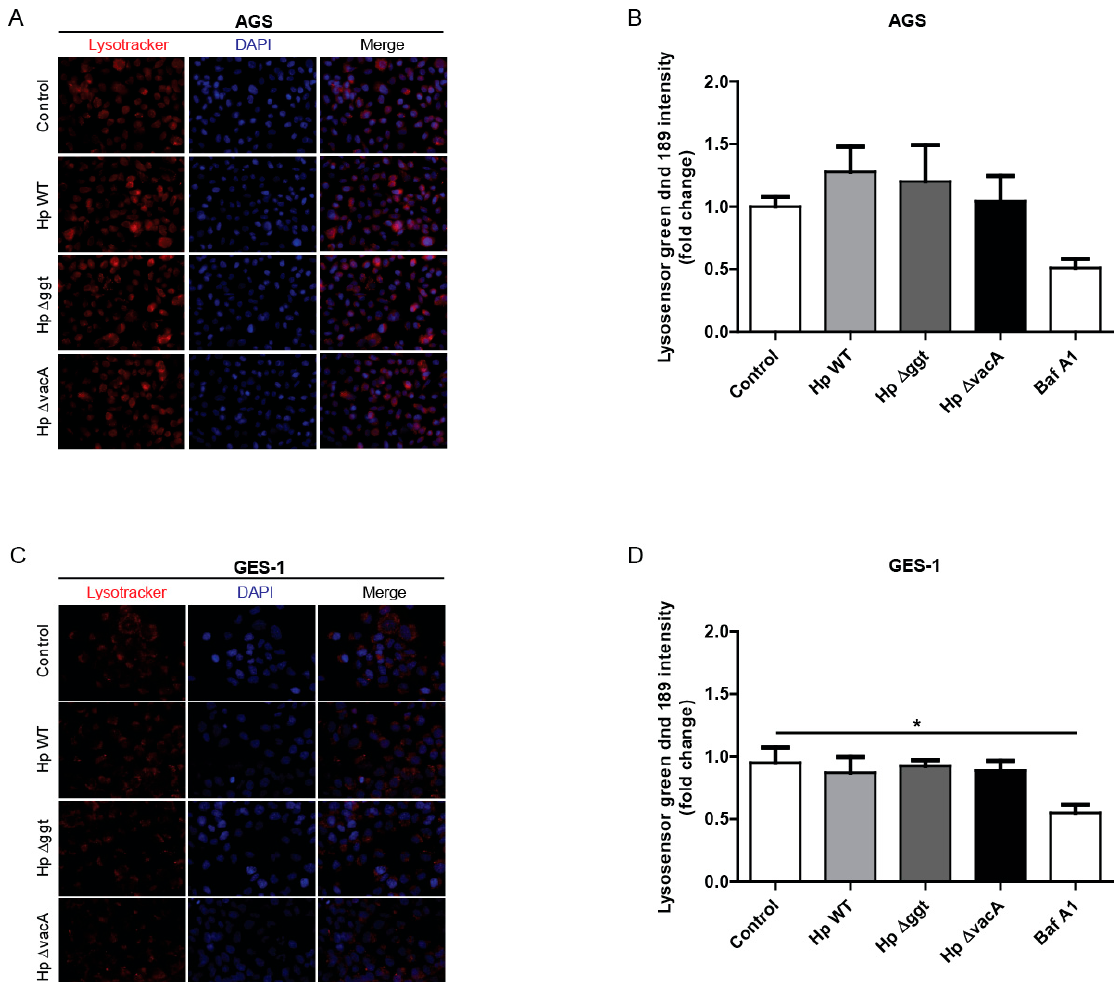
Figure 3. H. pylori infection did not affect lysosomal acidification in gastric cells. AGS and GES-1 cells were infected with H. pylori wild type (HpWT) or the isogenic Hp ∆ ggt and Hp ∆ vacA (lacking gamma-glutamyltranspeptidase and vacuolating toxin, respectively) mutant strains at a multiplicity of infection (MOI) of 100 for 6 h. ( A ) To visualize acidified compartments, ( A ) AGS and ( C ) GES-1 cells were treated with the acidotropic dye Lysotracker Red DND-99 (75 nM) for 2 h. Representative fluorescent images from three independent infection experiments are shown. To measure the lysosomal pH, ( B ) AGS and ( D ) GES-1 cells were treated with Lysosensor green DND-189 (1 µ M) for 30 min. Fluorescence intensity was evaluated by flow cytometry. Bafilomycin A1 (100 nM) was used as positive control to inhibit acidification. Data represent the mean ± the standard error of the mean (SEM) of at least three independent experiments. * p < 0.05.